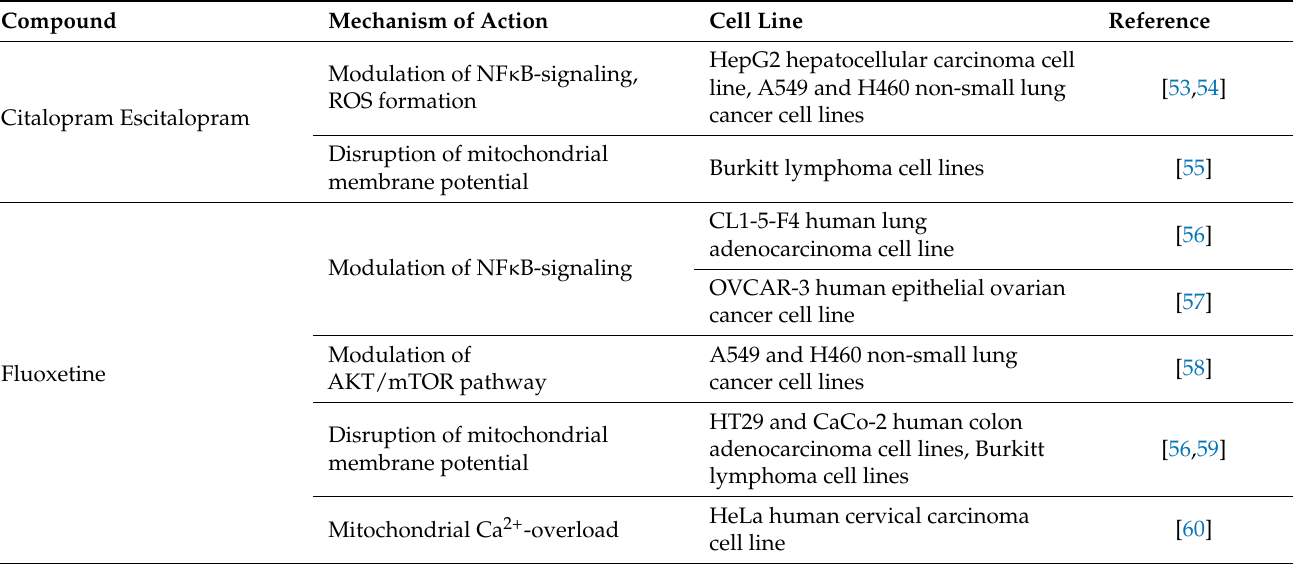
Table 1. Selective serotonin reuptake inhibitors (SSRIs) with anticancer